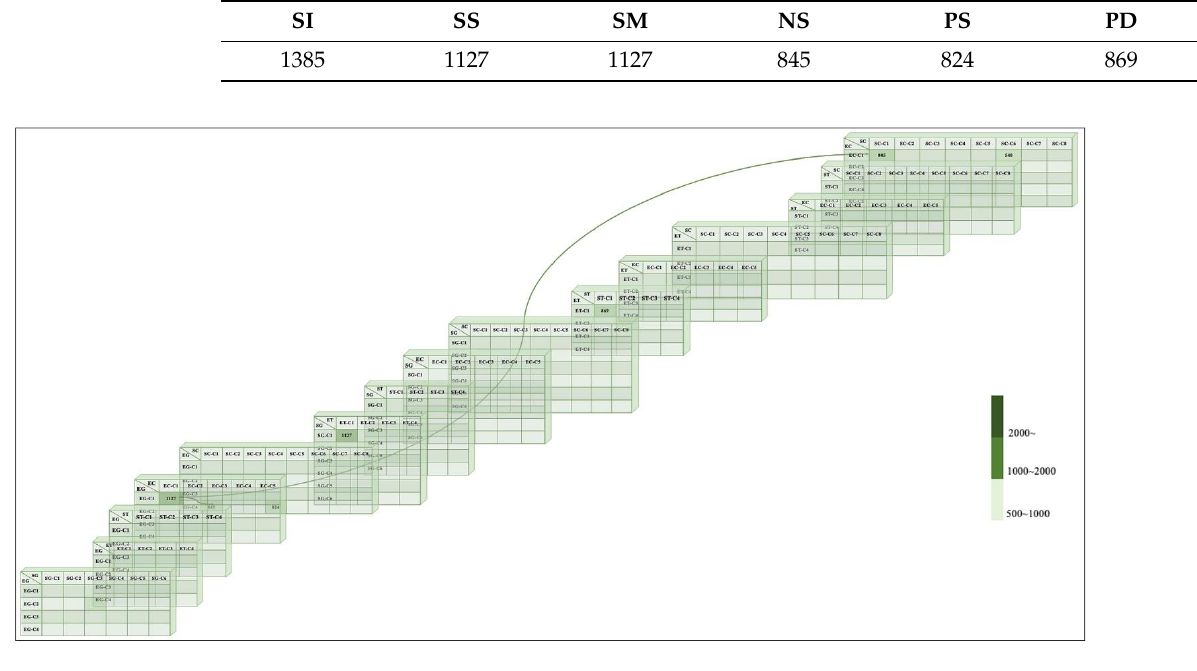
Figure 5. Proposed clustering.